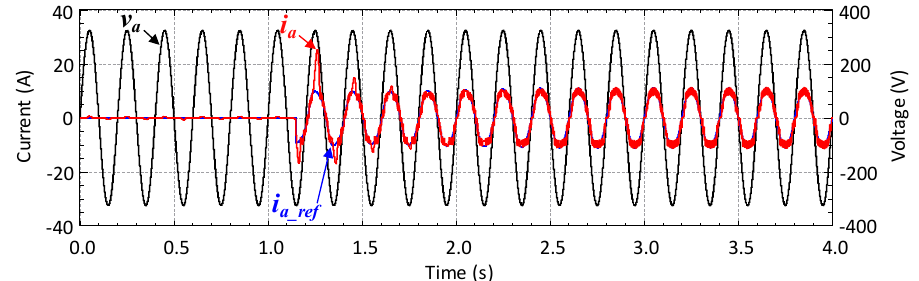
Figure 24. Simulation results of the current, reference current, and power grid voltage in G2V slow battery-charging mode.